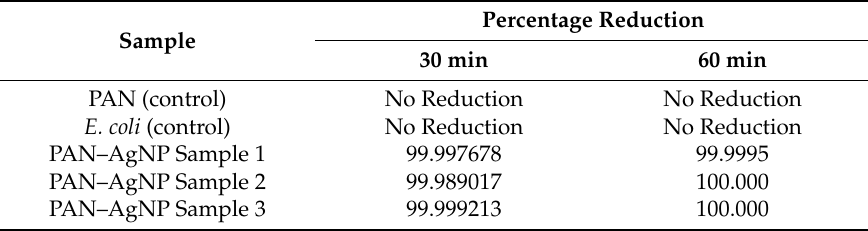
Table 1. Antimicrobial efficacy of AgNP on PAN membranes tested on Escherichia coli. Sample